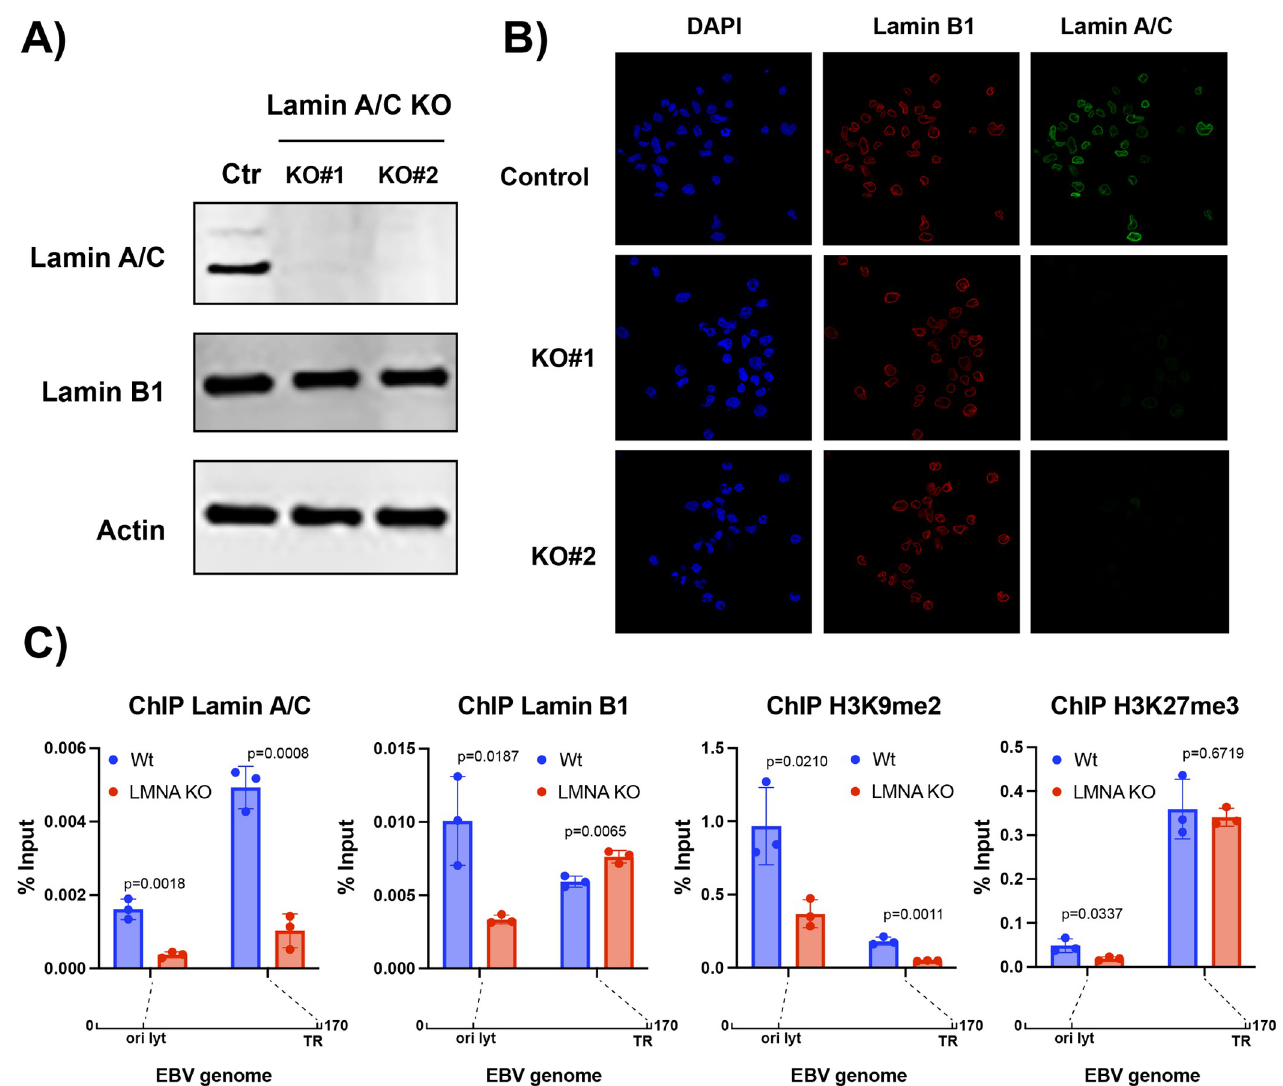
Fig 6. Lamin A/C knockout alters interaction of the EBV genome with the nuclear lamina and changes viral chromatin composition. A) Western blot analysis for lamin A/C, lamin B1 and actin protein expression in Ctr and LMNA KO GM12878 LCL cells. CRISPR/Cas9 gene editing was used to knock out lamin A/C expression in GM12878 cell lines using two different single-guide RNAs (sgRNAs) that target distinct regions of the LMNA gene. We generated two lamin A/C KO stable bulk populations. B) Immunofluorescence confocal microscopy analysis of Ctr and KO cells immunostained with lamin A/C (green) and lamin B1 (red) antibodies and DAPI (blue). C) Quantitative chromatin immunoprecipitation (ChIP-qPCR) analysis of EBV chromatin extracted from Ctr and LMNA KO GM12878 cells. EBV chromatin was analyzed for the binding of lamin B1 and lamin A/C and the deposition of the repressive histone marks H3K9me2 and H3K27me3 at the indicated regions. Data are presented as %input. N = 3, Mean ± SD. The t test p values for the KO/ctr comparison are